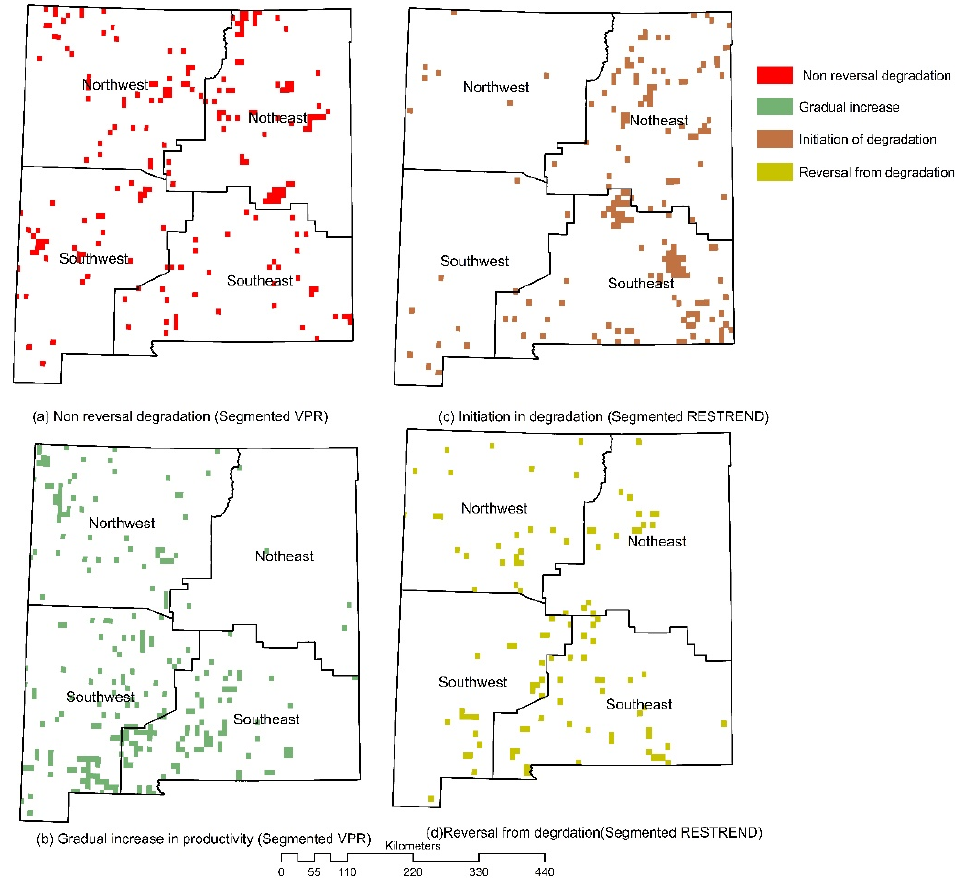
Figure 8. Direction of change in productivity in New Mexico’s quadrants during the 1982–2015 period indicating ( a ) non reversal degradation, ( b ) gradual increase, ( c ) initiation of degradation, and ( d ) initiation of reversal from degradation along with the corresponding methods used.